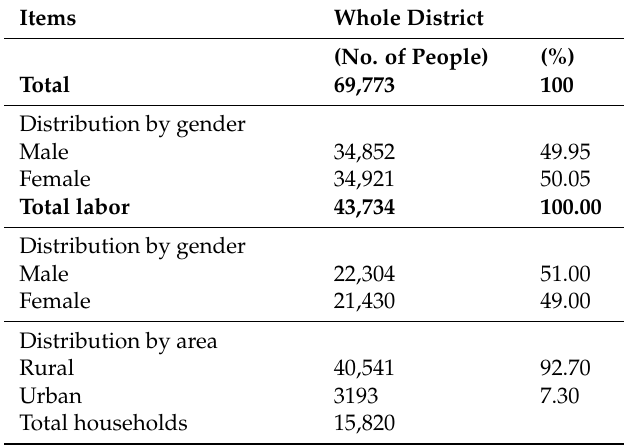
Table 1. Socio demographic characteristics of Con Cuong District, Nghe An Province, Vietnam,